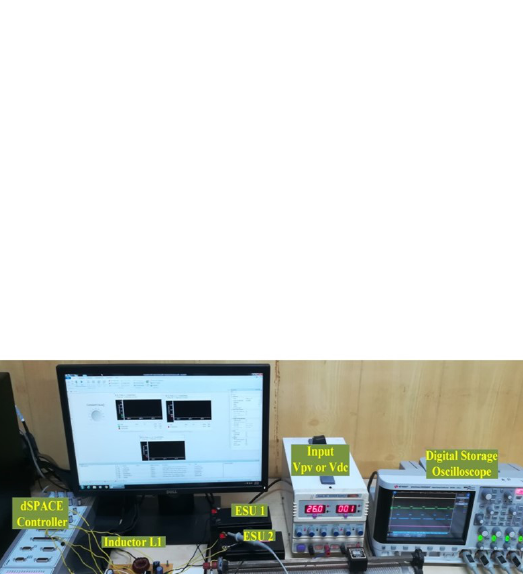
Fig. 4. Control strategy using dSPACE